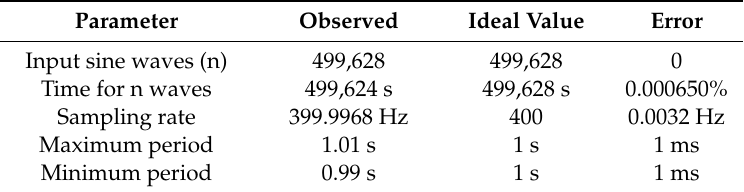
Table 4. Summary of observed parameters from long-term continuous operation test and expected